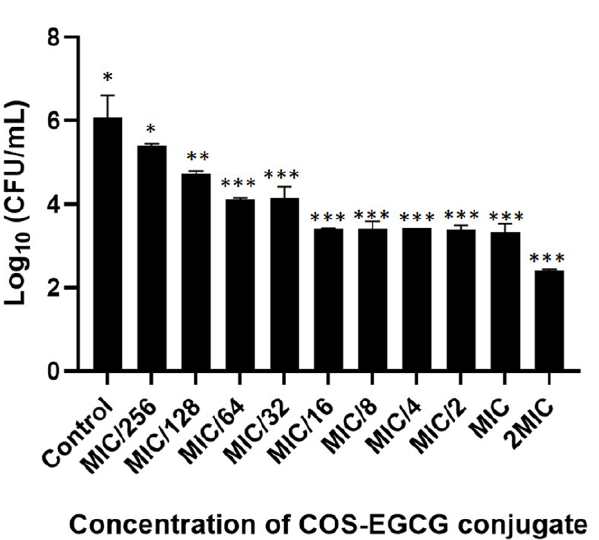
Figure 3. Inactivation of the biofilm of L. monocytogenes after treatment with COS-EGCG conjugate at different concentrations in comparison with the control. The different asterisks on the bars denote significant differences ( p < 0.05). The results are presented as means ± SD ( n = 3) .